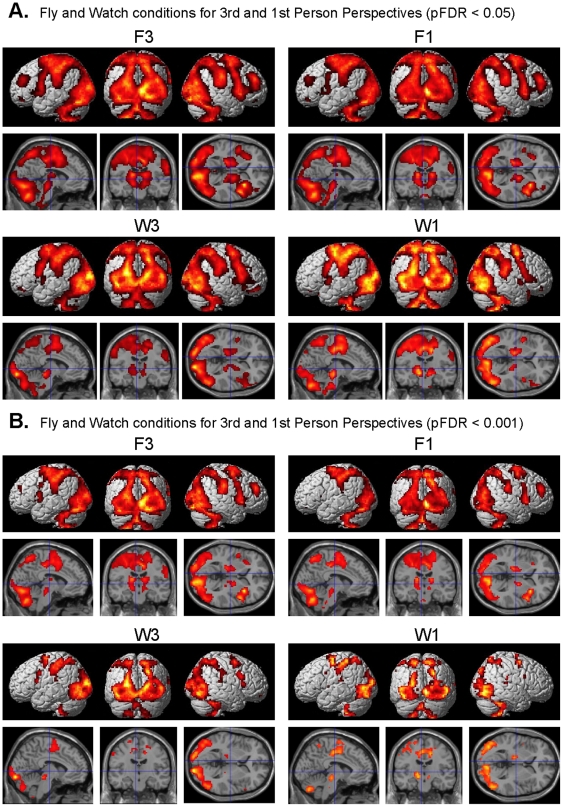
Differential activity rendered on the surface of the brain.A. Random-effects results rendered on the normalized brain of the 3rd person flying condition (F3), the 1st person flying condition (F1), the 3rd person watching condition (W3), and the 1st person watching condition (W1) relative to the baseline rest condition (pFDR <0.05 corrected for multiple comparisons). B. Same as above but using pFDR <0.001 corrected for multiple comparisons.